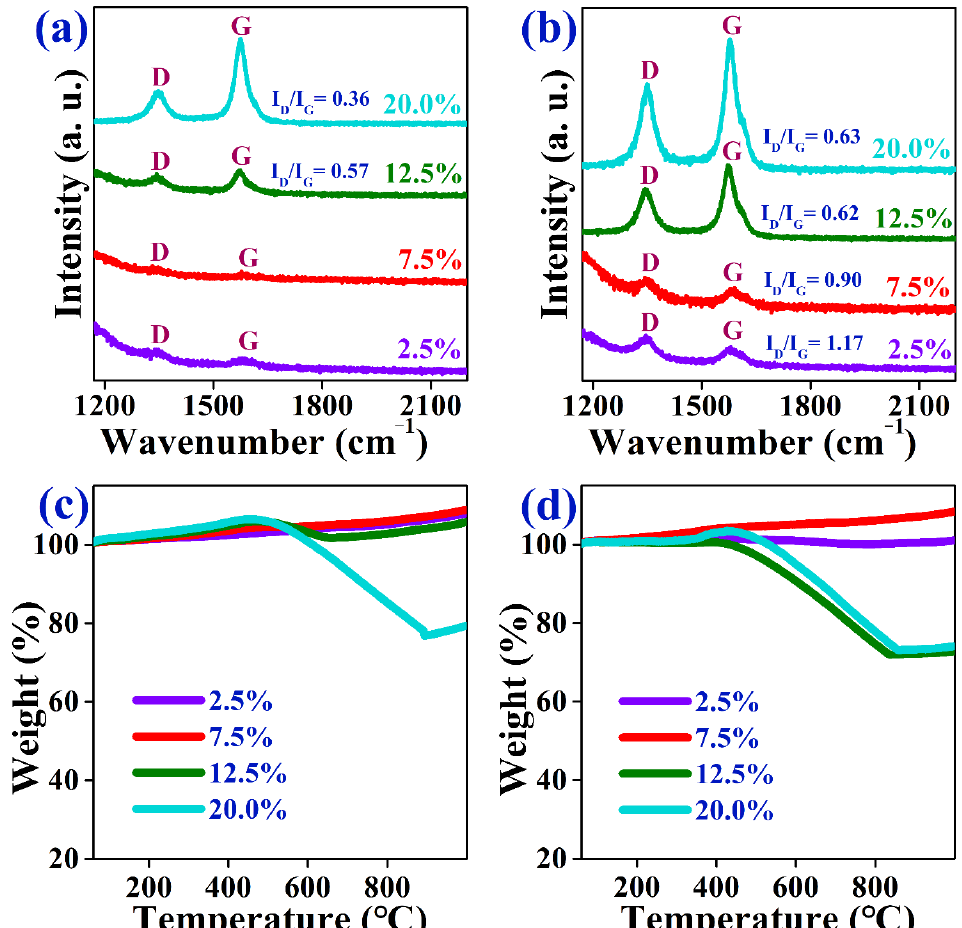
Figure 10. Raman spectra and TGA data of the used catalysts. ( a , b ) Raman spectra of the Ni@CeO 2 catalysts prepared at different Ni-loadings (2.5, 7.5, 12.5, and 20 wt%) after operating the DRM reaction for 50.0 h, at temperatures of 800 °C ( a ) and 700 °C ( b ). ( c , d ) TGA profiles of Ni@CeO 2 catalysts after operating the DRM reaction for 50.0 h at a temperature of 800 °C ( c ) and 700 °C ( d ). Figure 10b shows the Raman spectra of the spent catalysts after performing the DRM process for 50.0 h at 700 °C. The first peak (D) is attributed to the structural defects and lattice distortions in the sp 3 -hybridized carbon systems, and the second peak (G) is related to the in-plane vibrations of the sp 2 -bonded carbon atoms with a high degree of symmetry and graphitization [9]. It is clear that increasing the Ni-loading resulted in decreasing the I D /I G ratio, suggesting that the high loading of Ni enhances the graphitization degree of the deposited carbon. The high intensities of the D and G bands for the carbon formed on the Ni@CeO 2 /12.5 and Ni@CeO 2 /20 catalysts suggest a high content of carbon deposited on their surfaces. Moreover, the carbon showed I D /I G ratios of 0.62 and 0.63, indicating the high graphitization degree of carbon deposited on the catalysts’ surface during the DRM process, which is very harmful to the catalytic performance, where the highly graphitized carbon is difficult to remove from the surface of the catalyst. This drives the blocking of the Ni-active sites and eventually a deterioration in the catalysts’ activity. Figure S5b shows the Raman spectra for Ni@CeO 2 /12.5 and Ni/CeO 2 /12.5/Impreg catalysts, where the